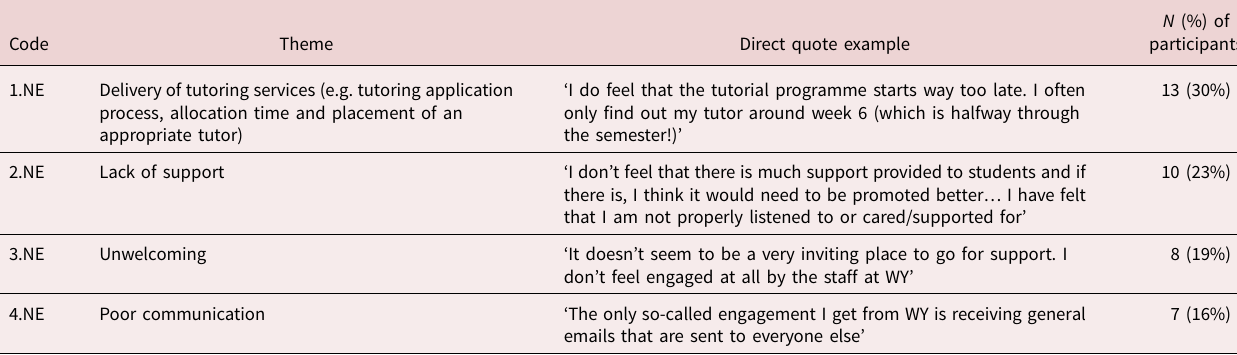
Table 3. Content analysis of negative experiences with Wirltu Yarlu ( N =43)